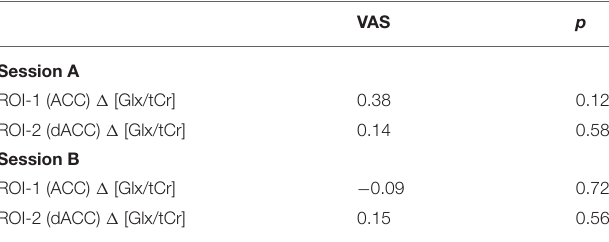
TABLE 4 | Correlations with changes in Glx/tCr across REST and PAIN conditions and pain